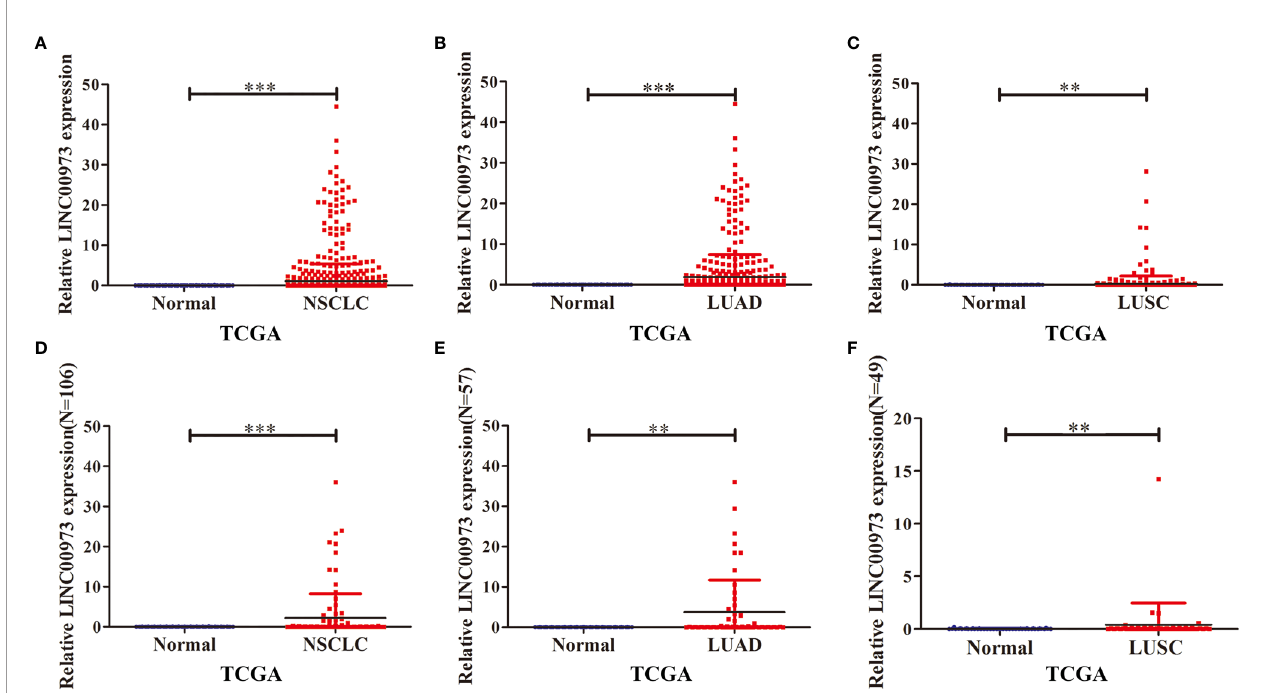
FIGURE 1 | LINC00973 expression was elevated in NSCLC tissue in the TCGA database. (A – C) Expression of LINC00973 in unpaired samples of NSCLC, LUAD and LUSC; (D – F) Expression of LINC00973 in paired samples of NSCLC, LUAD and LUSC. NSCLC, Non-small cell lung cancer; LUAD, lung adenocarcinoma; LUSC, lung squamous cell carcinoma; Normal, normal tissues; TCGA, The Cancer Genome Atlas; **P < 0.01; ***P <